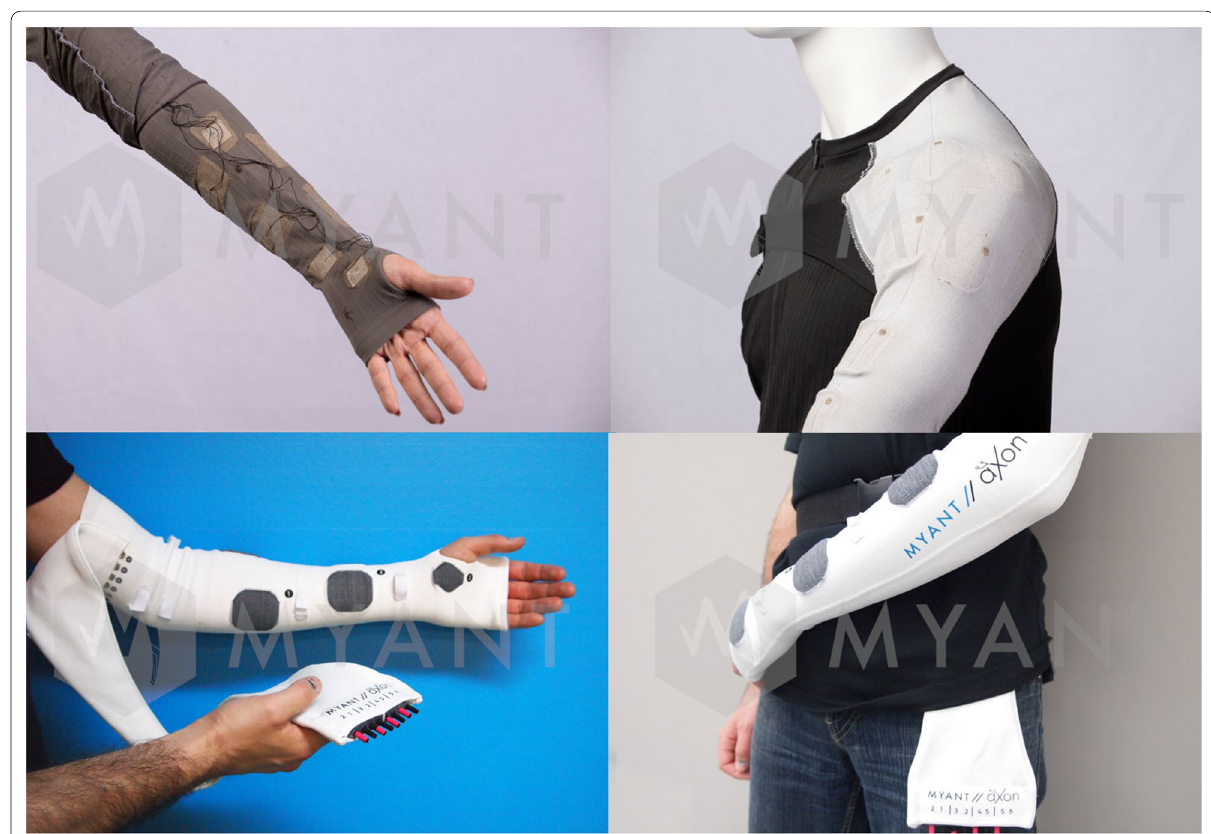
Fig. 4 Myant wearable garments. Garments can be worn under clothes and provide stimulation through electrodes embedded into clothing. Permission to print photos granted by Myant (Toronto,